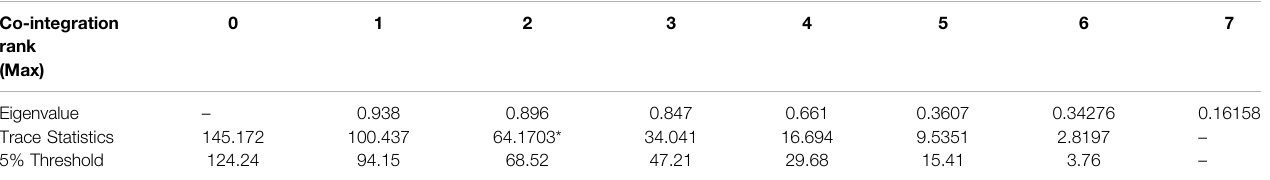
TABLE 6 | Johansen test result.